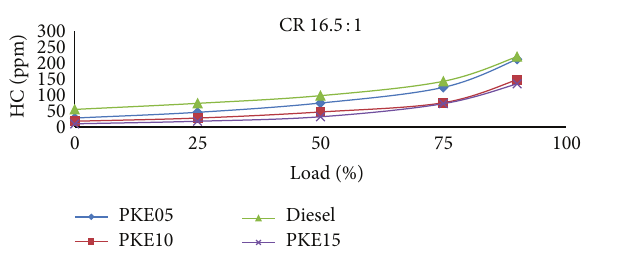
Figure 16: Load versus NO 𝑥 emissions at 14 :1 CR.